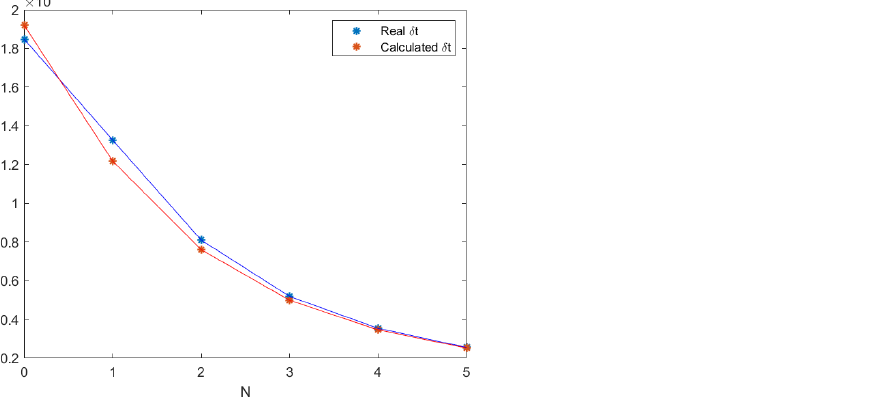
Figure 12. Inner time step size δ t computed using numerical eigenvalue spectrum (real, blue) and formula (29) (calculated, red) depending on different number of moments N shows good